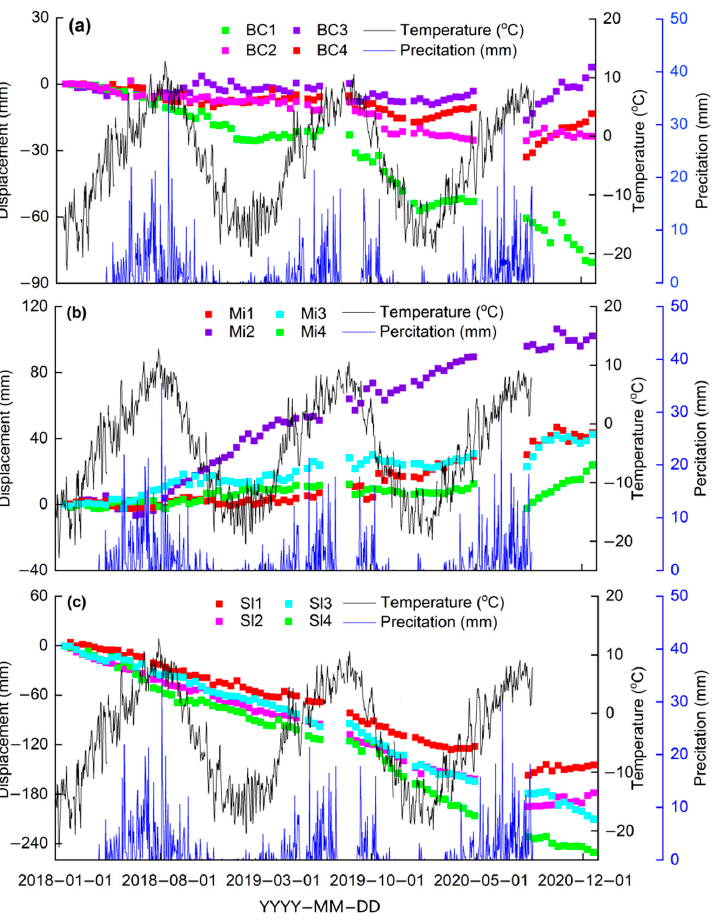
Figure 5. Time series displacement of typical points in mining area. ( a ) BC1 to BC4: typical points in mine building and finished coal area; ( b ) Mi1 to Mi4: typical points in mine area, and; ( c ) Sl1 to Sl4: typical points in slag area.